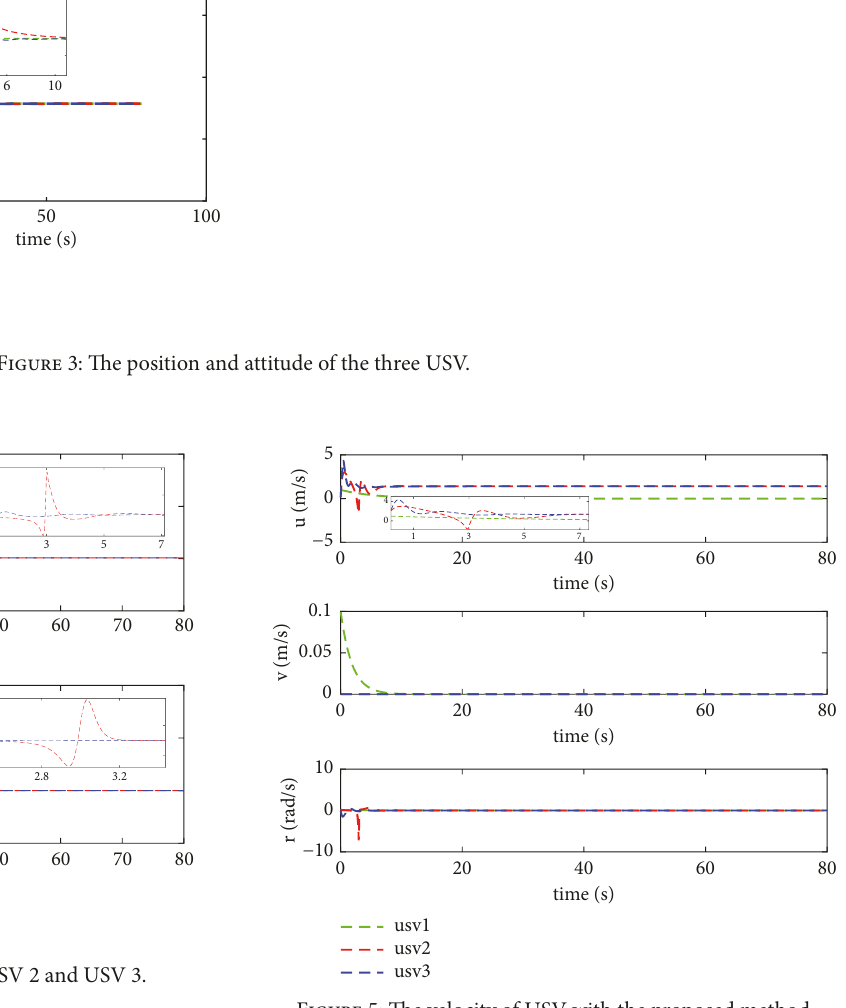
Figure 5: The velocity of USV with the proposed